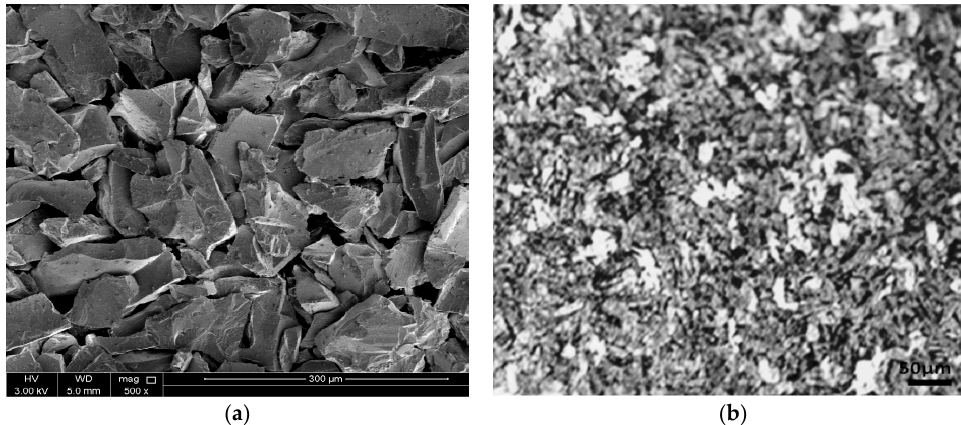
Figure 1. SEM micrographs of ( a ) aluminum oxide particle size distribution, ( b ) microstructure of the target materials (API X120).